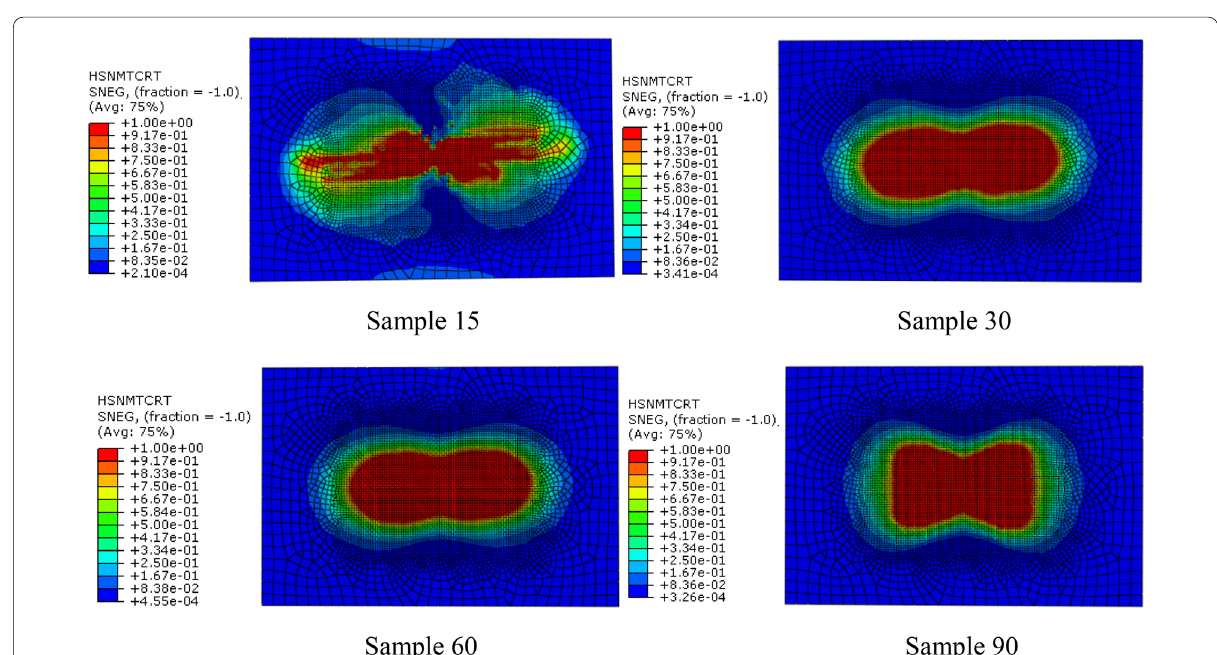
Fig. 10 Distribution nephogram of matrix tensile failure of four bionic models with different helix angles when impact energy is 20